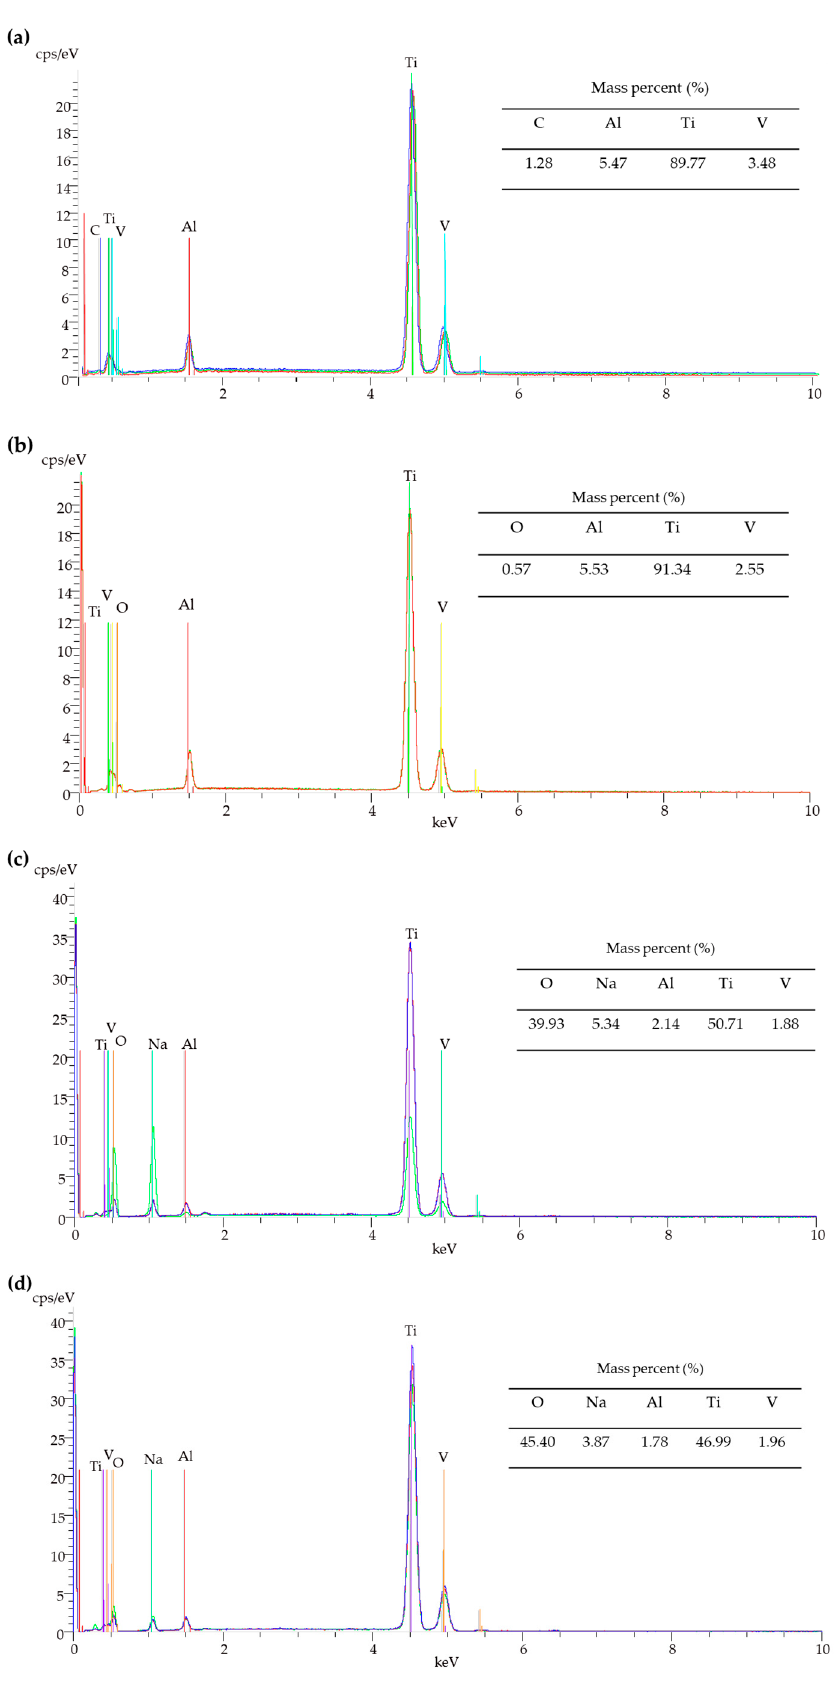
Figure 2. Energy-dispersive spectroscopy (EDS) spectra and quantitative data of the T ( a ), T5 ( b ), T-S ( c ), and T5-S ( d ) samples.